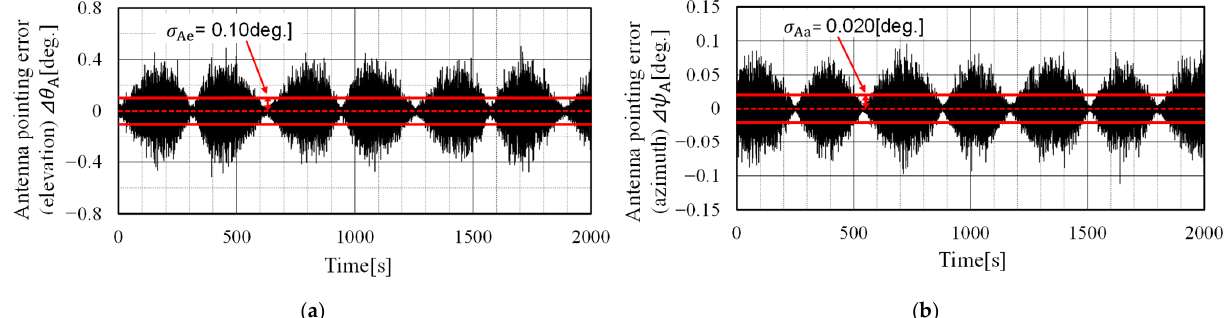
curacy directions. ( a ) Elevation. ( b ) Azimuth. Figure 25. Time history of the antenna’s pointing control errors using RF sensor with 0.01 deg. ac-